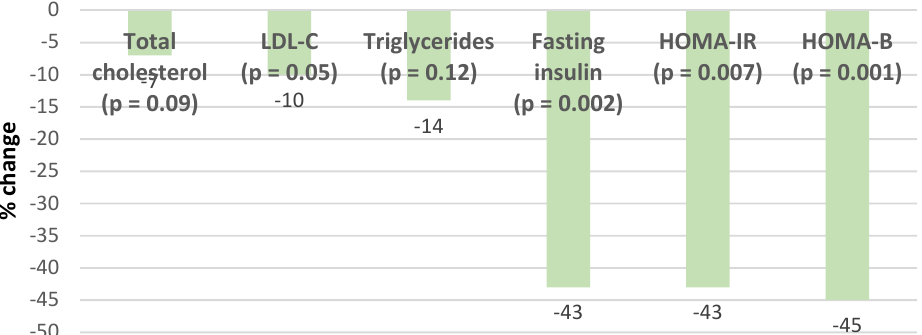
Figure 35. Change (%) in metabolic risk biomarkers between the almond diet and nut-free control diet for baseline to 16 weeks during a weight maintenance diet in prediabetic individuals [62].